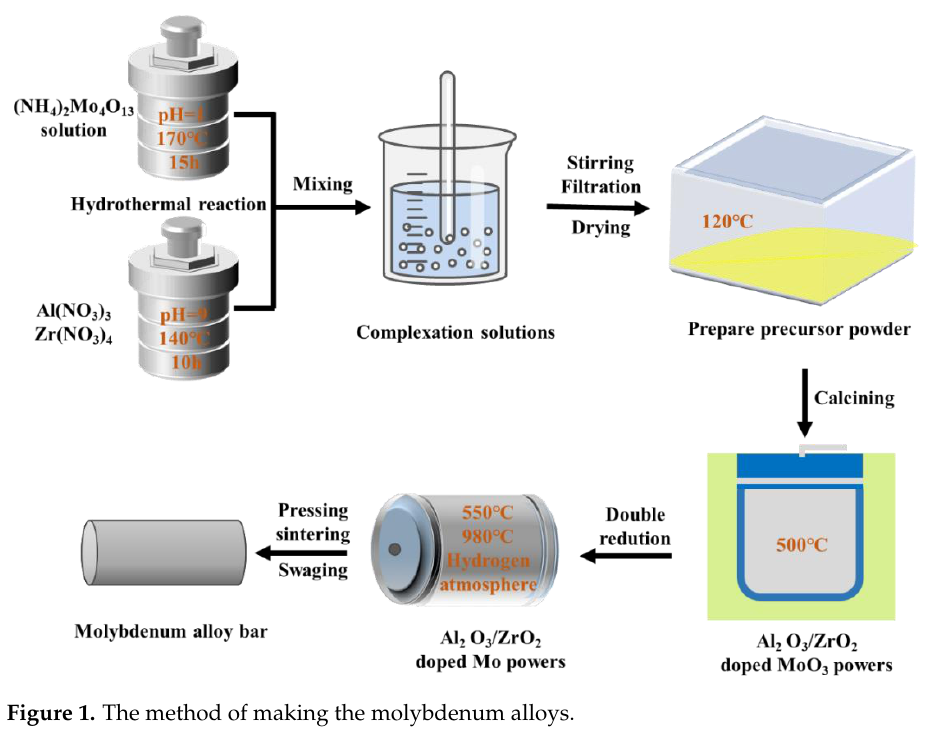
Figure 1. The method of making the molybdenum alloys.